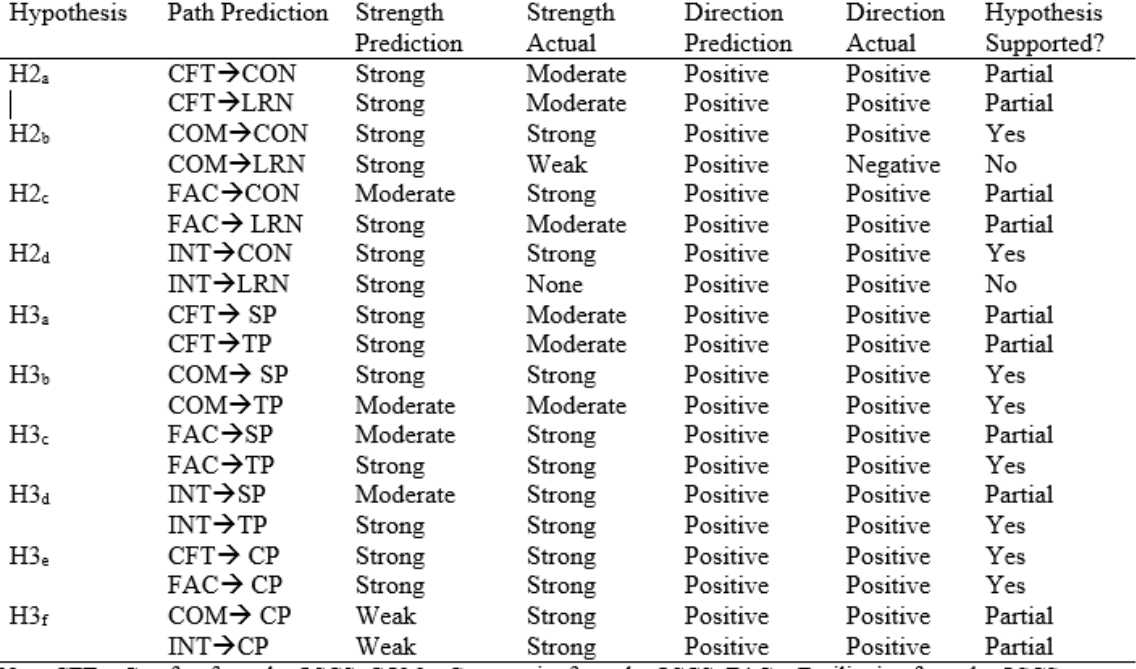
Based on these results, the final nomological network model was altered. Figure 3 shows the final directional paths and strengths between factors form the OSCS, COI, and